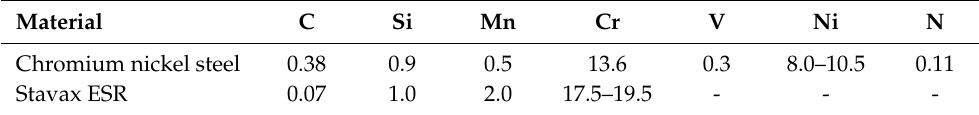
Table 1. Chemical composition (mass fractions in %) for stainless steel samples and Stavax.